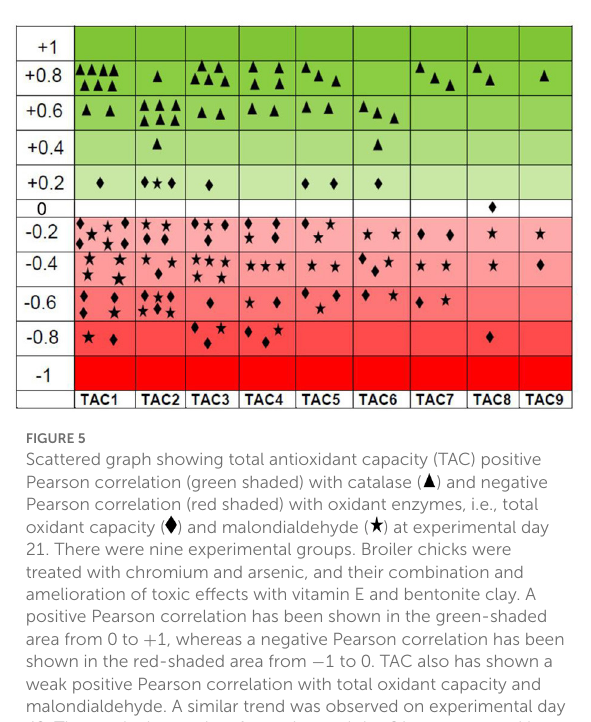
FIGURE5 Scattered graph showing total antioxidant capacity (TAC) positive Pearson correlation (green shaded) with catalase ( ) and negative Pearson correlation (red shaded) with oxidant enzymes, i.e., total oxidant capacity ( ) and malondialdehyde ( ) at experimental day 21. There were nine experimental groups. Broiler chicks were treated with chromium and arsenic, and their combination and amelioration of toxic effects with vitamin E and bentonite clay. A positive Pearson correlation has been shown in the green-shaded area from 0 to + 1, whereas a negative Pearson correlation has been shown in the red-shaded area from − 1 to 0. TAC also has shown a weak positive Pearson correlation with total oxidant capacity and malondialdehyde. A similar trend was observed on experimental day 42. Thus, only the results of experimental day 21 are presented